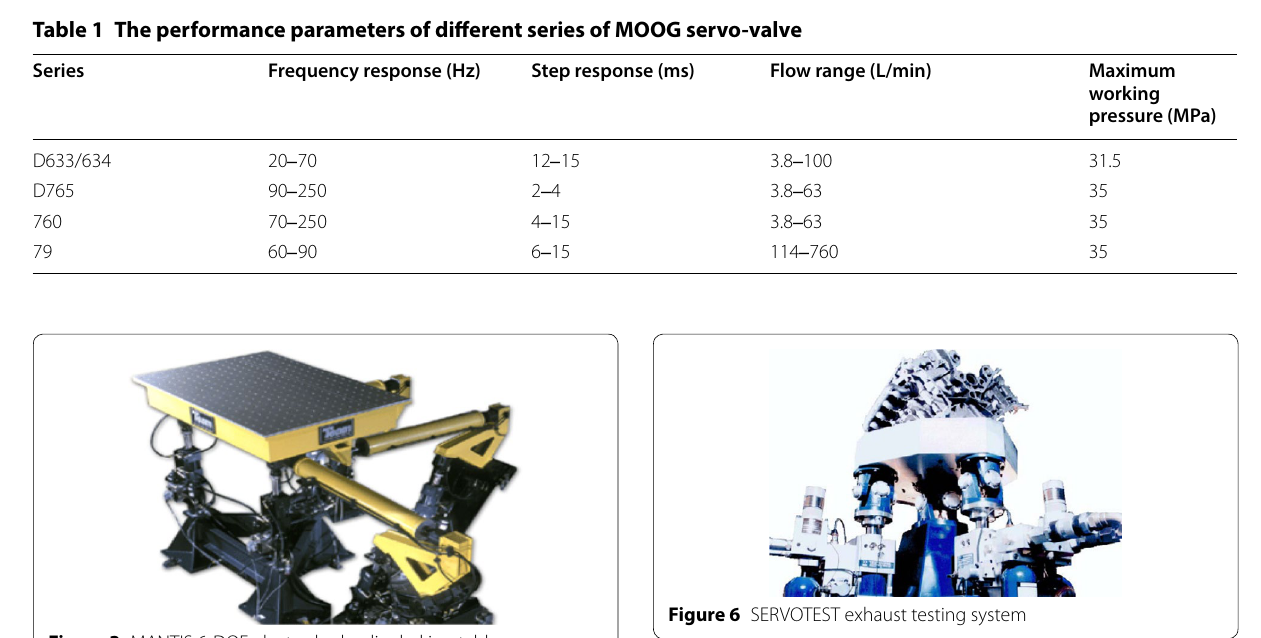
Figure 3 MANTIS 6-DOF electro-hydraulic shaking table